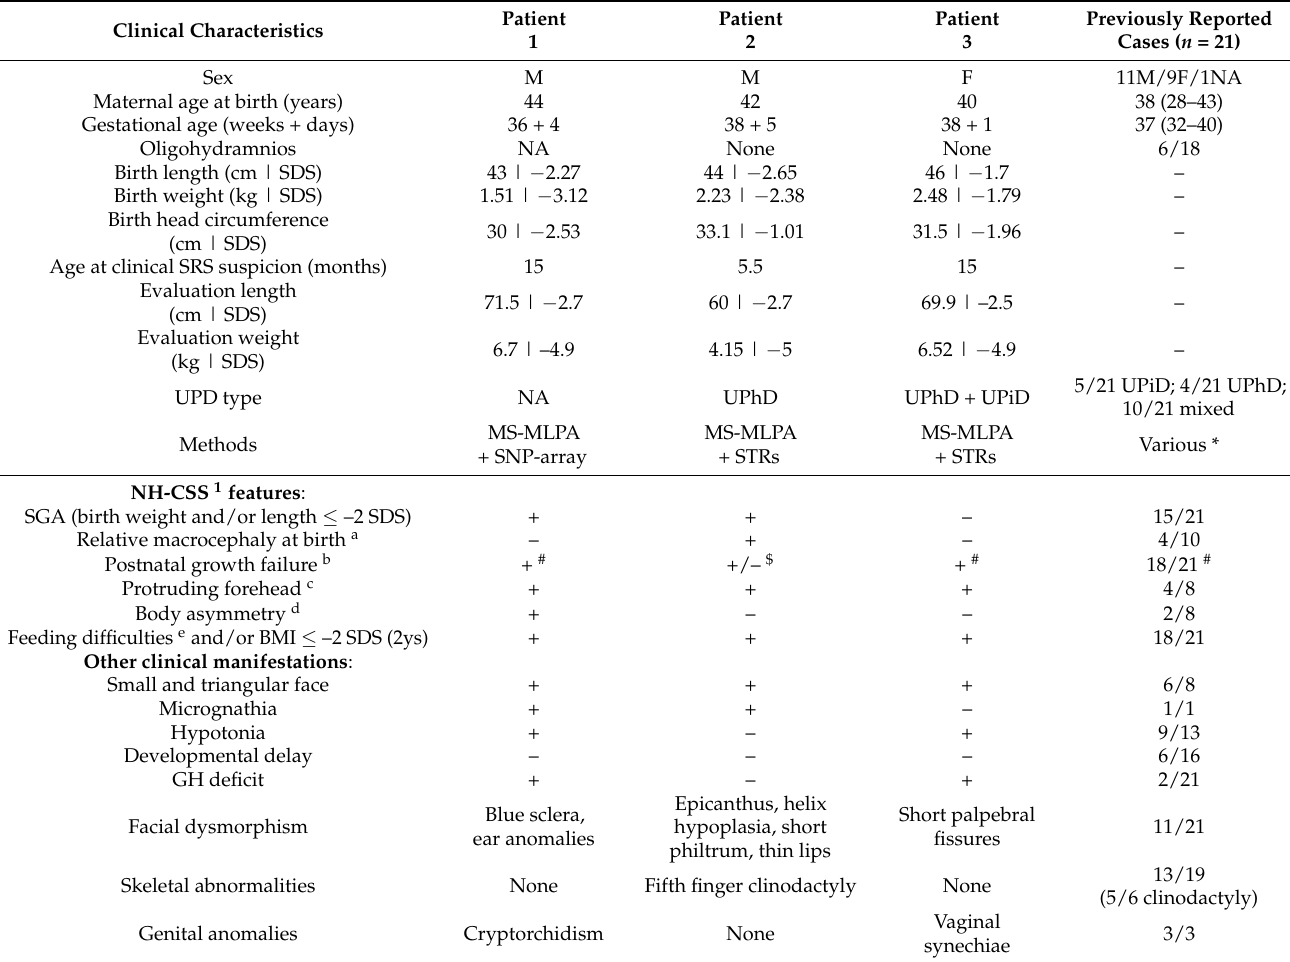
Table 1. Clinical features of the three new UPD(20)mat patients described here and previously reported cases. Clinical